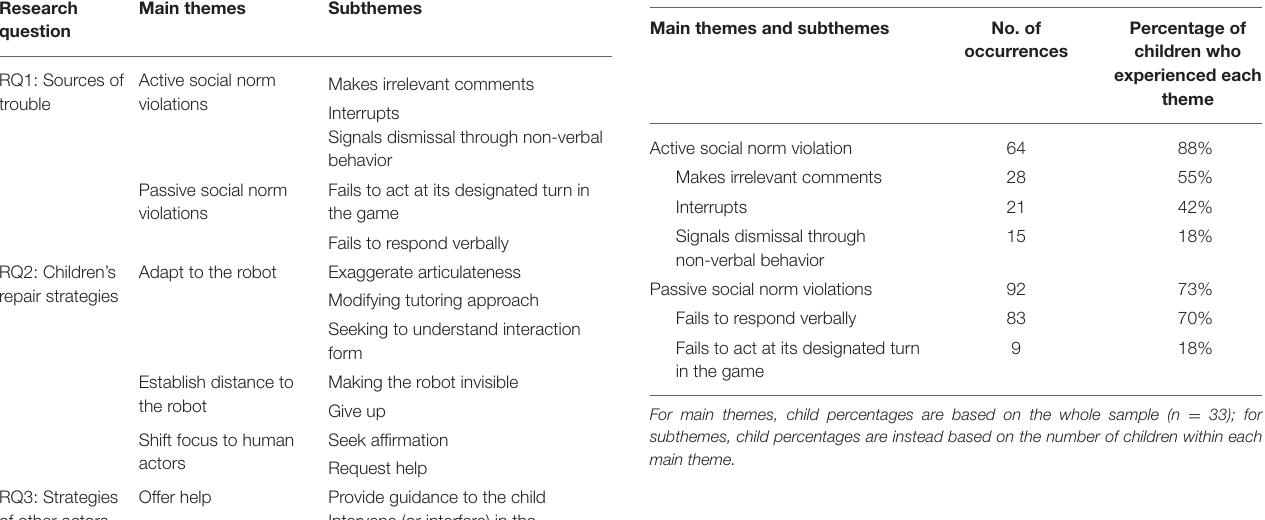
TABLE 2 | Number of occurrences and children who encountered each source of